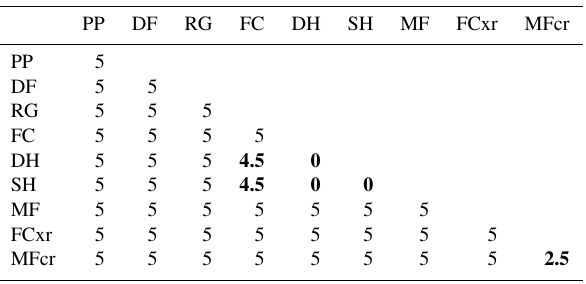
Table 2. Weighting scheme for preferential layer matching; the preferential layer matching coefficient ν(g 1 ,g 2 ) depends on the combination of two grain types g 1 and g 2 ; the smaller the coeffi- cient, the more preferably the grain type combinations are matched (bold font). Values in the upper triangle are symmetric to values in the lower triangle.